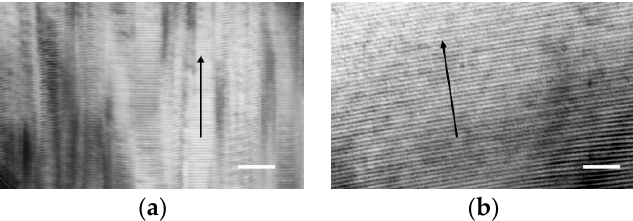
Figure 4. TEM cross-section of AlN/AlGaN SPSLs (courtesy of Dr. S. N. G. Chu) ( a ) grown directly on bare (0001) sapphire; ( b ) grown on ~50 nm thick AlN buffer layer. The white scale bars are 20 nm long. The [0001] direction is shown by black arrows.